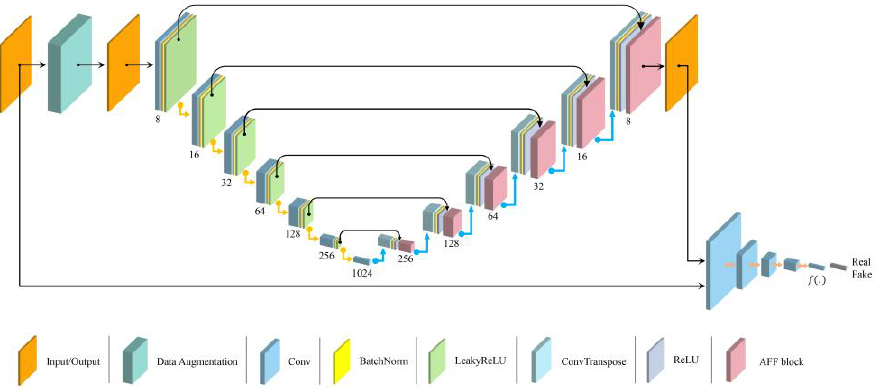
Figure 2. The architecture of the network used in our method.